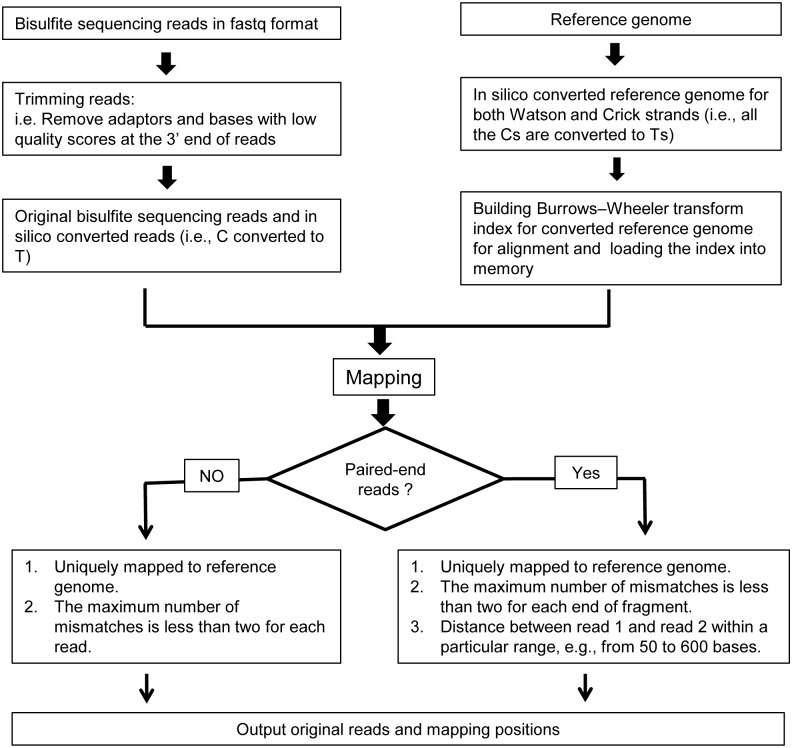
Principle of bisulfite sequencing read alignment by BSAligner.Firstly, the low-quality bases and sequenced adaptors at the 3′ ends of the reads are removed. The preprocessed reads are then mapped to C-to-T converted reference genomes whose Burrows-Wheeler Transform (BWT) indices are created and loaded to computing memory before executing alignment. Paired-end reads and single-end reads use different alignment strategies: (1) For single-end reads, they are mapped to reference genome by allowing at most 2 mismatches and only uniquely mapped reads are kept for further analysis; (2) For the paired-end reads, in addition to considering the number of mismatches and aligned hits, the insert size between the paired-end reads are also taken into account (e.g., from 50 to 600 bases); (3) The ambiguous reads that are mapped to both Watson and Crick strands are removed. Finally, the alignments are outputted in a text file which records the aligned chromosomes, positions, mismatches as well as sequencing qualities etc.